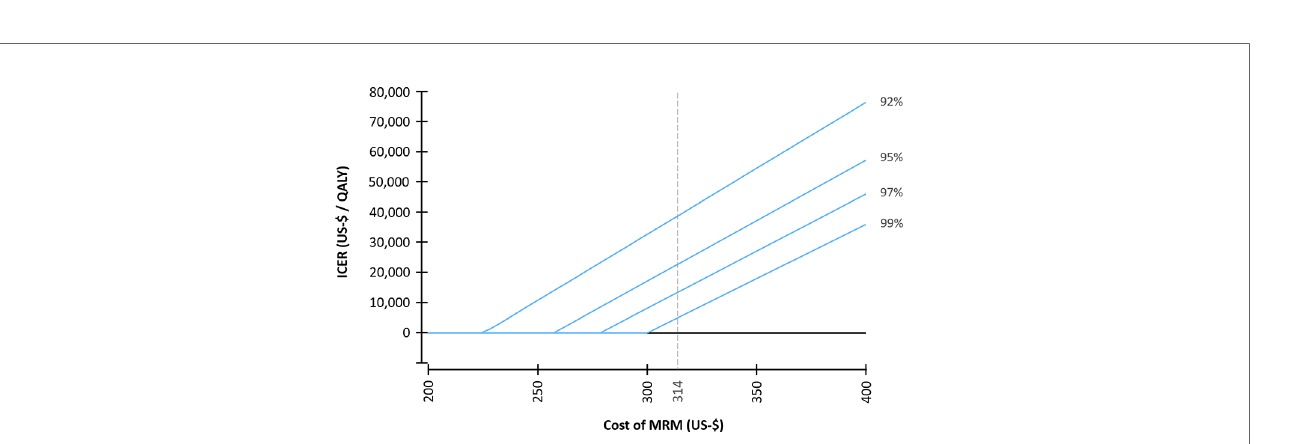
FIGURE 3 | Incremental cost-effectiveness ratio (ICER) for varying costs of MR-mammography (MRM). A speci fi city of MRM of 92% was selected for the fi rst screening round. For the subsequent screening rounds, varying speci fi cities (92% - 99%) were assumed. An average cost per examination of $ 314 was assumed for MRM in the base case